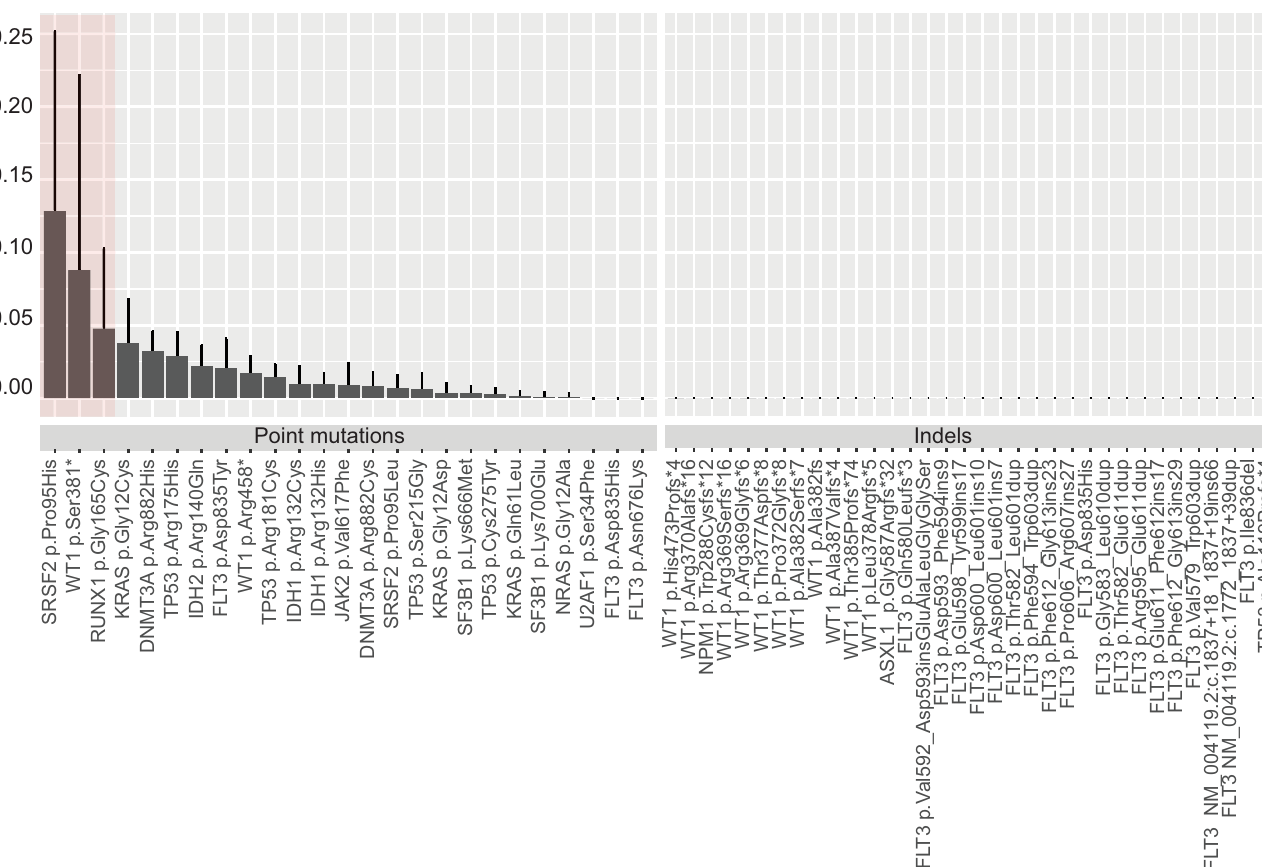
Fig 3. Specificity of the MRD assay. All trackable mutations included in this study (at relapse for RG and diagnosis for NRG, total = 59) were queried in the NRG samples. Pathogenic variants are listed at protein level change whenever possible. In the few instances where the protein change could not readily defined (e.g. FLT3 ITDs involving an intron/exon boundary), RNA level change along with the transcript used is provided. The average VAF detected in the negative control (NRG) is shown in the histogram plot with standard deviation error bars. Only 3/59 variants were detected at or above 0.1% VAF, the desirable limit of detection. These variants are highlighted in a red box and were excluded from further